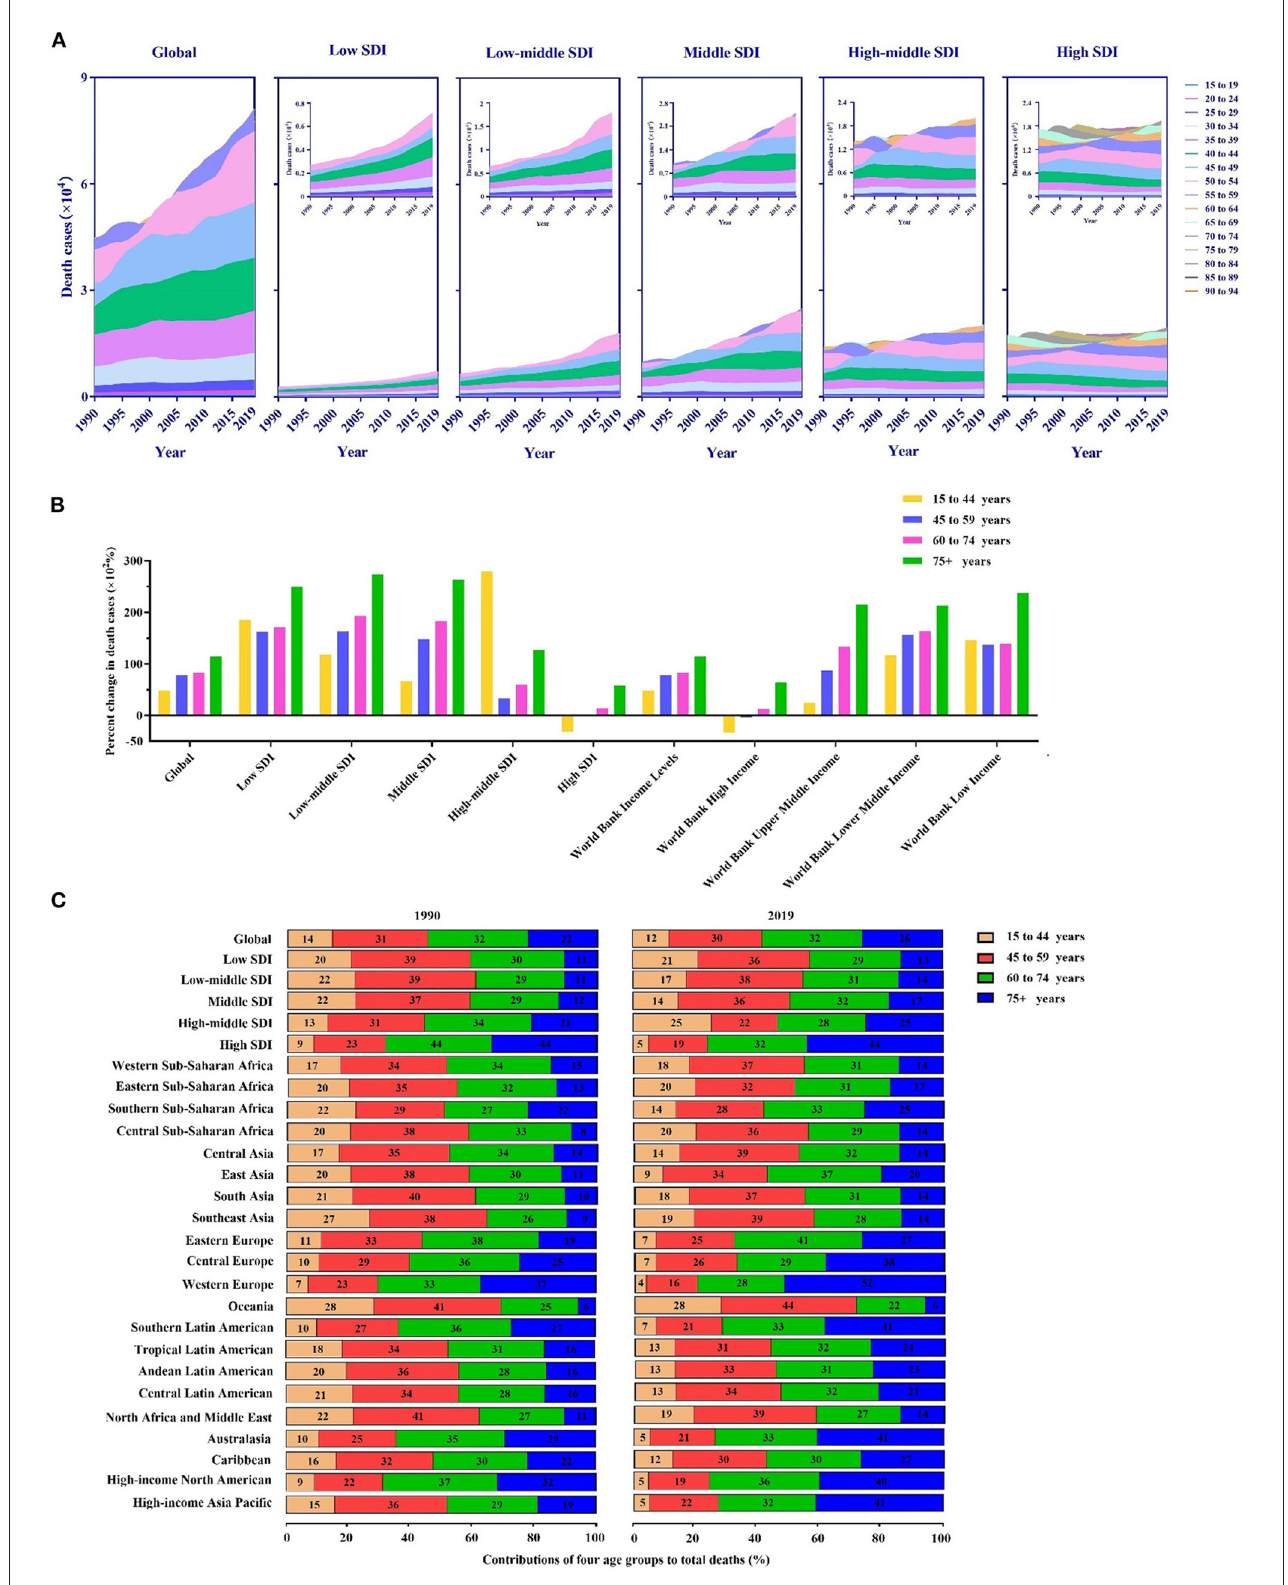
FIGURE2 Death cases of breast cancer and their changes by age groups in different regions. (A) The contribution of each age group (15–94 years) to the total number of deaths between 1990 and 2019 globally and in territories with a low to high sociodemographic index (SDI). (B) Percentage changes in deaths in the four age groups (15–44 years, 45–59 years, 60–74 years, and 75–94 years) between 1990 and 2019 globally and in territories with a low to high SDI. (C) The four age groups as percentages of the total number of deaths globally and in territories with a low to high SDI and in 21 global burdens of disease (GBD) regions in 1990 and